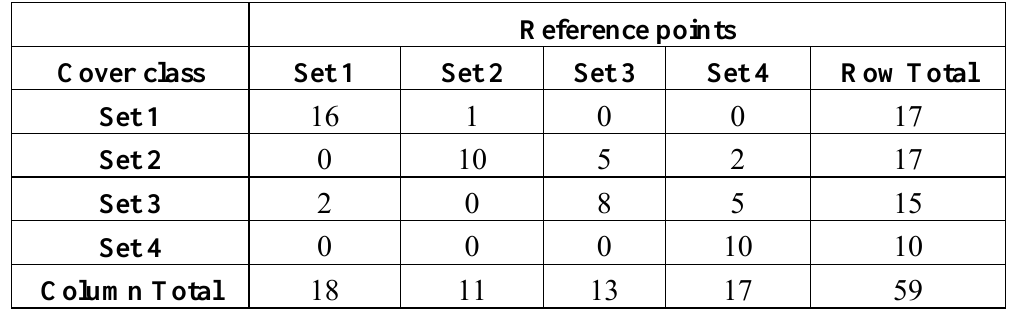
Table 1A. Sample of classification result error matrix of the corrected image (image 1, Milwaukee urban (Scene ID#:Y5013916033x07).